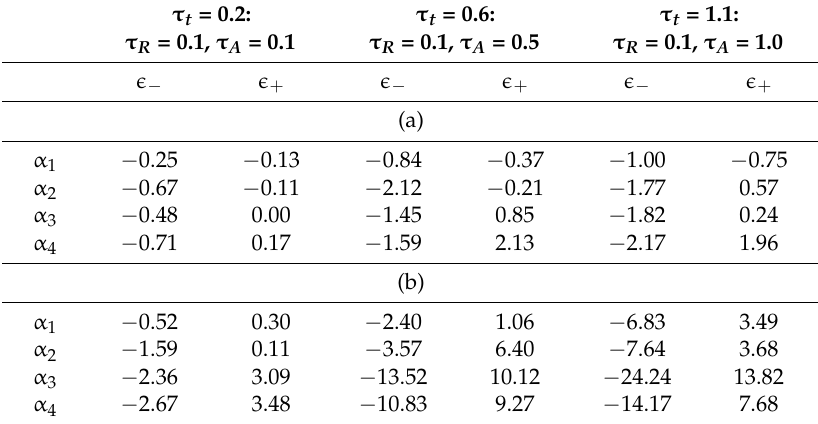
Table 3. Relative confidence intervals, Equation (15), of the retrieved parameters of Nilson–Kuusk BRDF, Equation (13), retrieved from surface radiance using 10 sets of 60 (a), and 10 sets of 12 (b) randomly selected sun-to-sensor geometries for different optical thickness of the atmosphere.